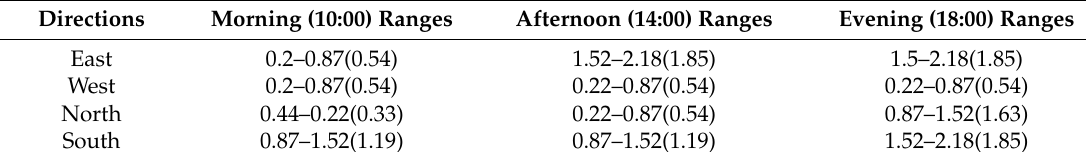
Table 6. Differences in T air at three time points in various directions under scenarios A and D.